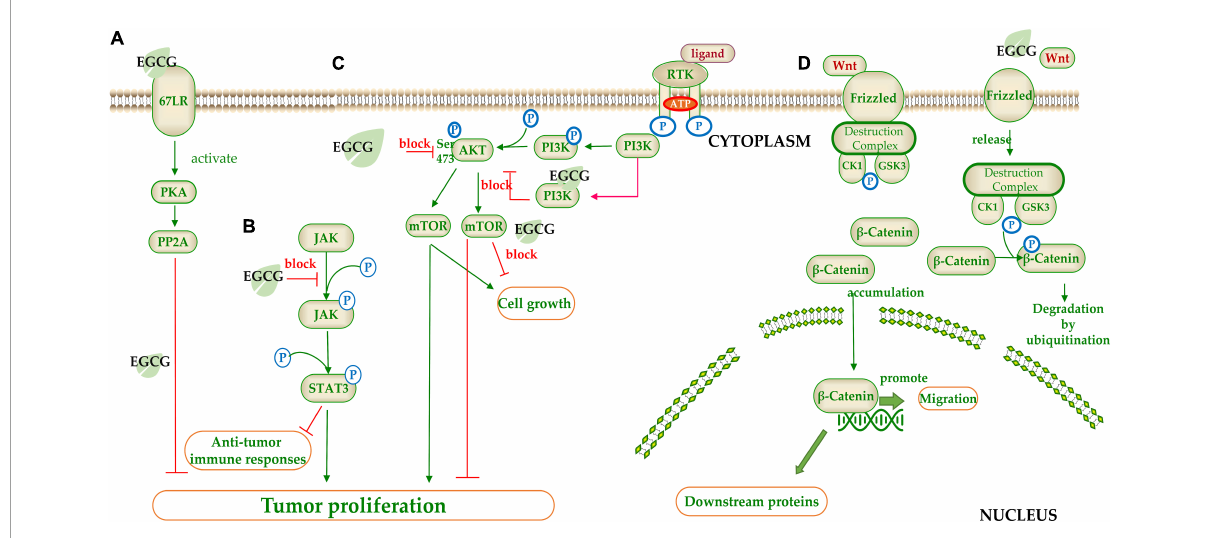
FIGURE4 The target of catechins in the signaling pathway. (A) 67LR/PKA/PP2A signal pathway; (B) JAK/STAT signal pathway; (C) mTOR/AKT signal pathway; (D) Wnt/ β -Catenin signal pathway. The green arrow represents the signal transmission, red arrow represents inhibition.